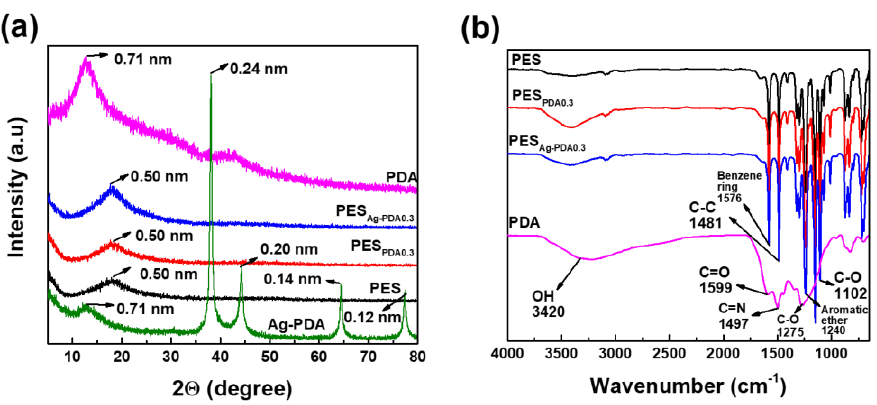
Figure 3. ( a ) XRD spectra of PES; PES PDA0.3 ; PES Ag-PDA0.3 ; PDA; and Ag-PDA. ( b ) Attenuated total reflectance-Fourier-transform infrared spectroscopy (ATR-FTIR) spectra of polyethersulfone (PES) and modified membranes. The samples were tested at room temperature. Table 2. Surface elemental composition of the membranes from XPS analysis. Membrane